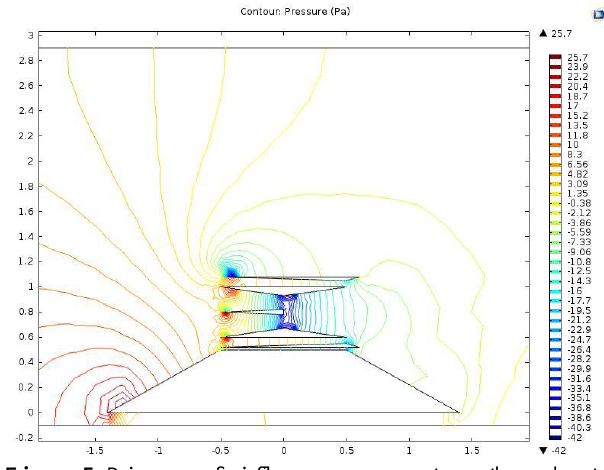
Figure 5. Diagram of airflow pressure contours throughout the closed type WPP construction and roof of the building To obtain velocity data in the turbine zone (a vertically arranged red line in Figure 6), a graph of the airflow velocity is plotted on the length of this zone, which is shown in Figure 7. The decrease of the velocity of airflow in the middle of the graph shows the shaded area of the closed- type WPP directive cone, where the generator and the turbine housing are located, and also the velocity growth on the both sides – the turbine blade area, where reached the maximum airflow velocity in the construction.